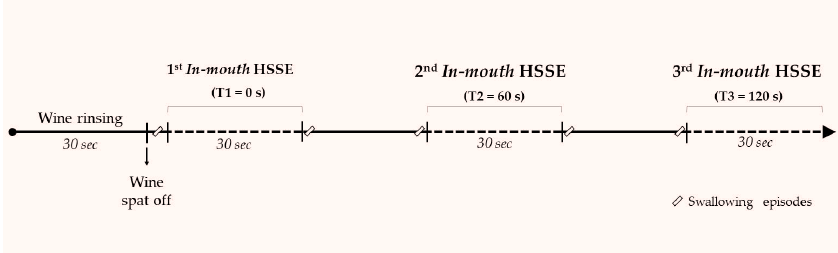
Figure 1. Sampling procedure followed for in-mouth HSSE aroma